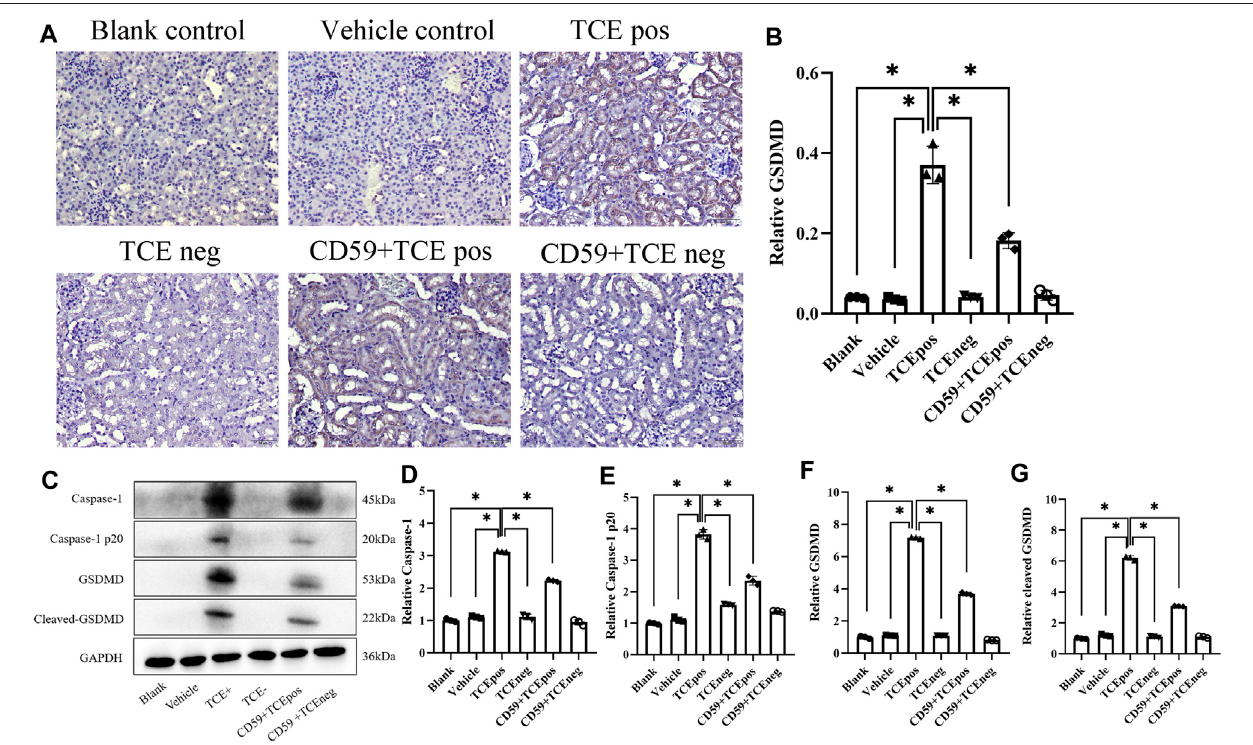
FIGURE 8 | C5b-9 promoted GSDMD-mediated RTEC pyroptosis in TCE-sensitized mice. (A) Expression of GSDMD in mouse kidney by IHC. All the scale bars represent 50 μ m n = 5/group. (B) Relative expression of GSDMD in kidney tissue assessed by average optical density value in Image J. (C) Representative immunoblot for expression of caspase-1, caspase-1 p20, GSDMD, and cleaved-GSDMD. (D – G) Relative expression of caspase-1, caspase-1 p20, GSDMD, and cleaved-GSDMD by optical density values in ImageJ. All the Westernblot tests for the abovementioned proteinswere repeated three times. n = 3 – 5/group. The data are expressed as the mean ± SD. Levels of signi fi cance were de fi ned as below: * p <